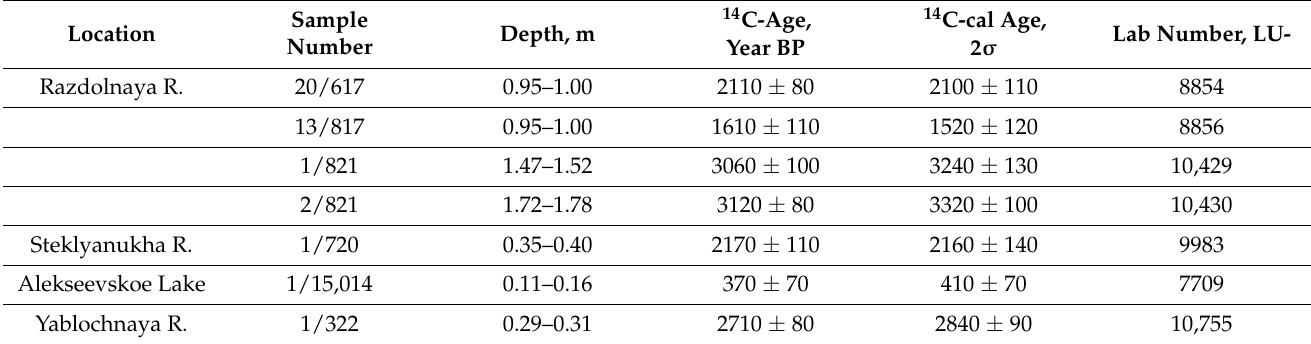
Figure 5. ( a ) Paleosol and deposits of strong floods on the floodplains of Razdolnaya (Suifun) River near Starorechenskoe Fortress, Southern Primorye (site 24 on Figure 2); ( b ) Deposits of the floodplain, Kurilka River, Iturup Island, Southern Kuril Islands—the deposits include marker tephra layers Ta-a (1739 CE) from the eruption of Tarumai Volcano, Hokkaido. Table 1. Radiocarbon dating results and calibrated ages of the paleosol from flood-plain sequences and wetlands near the mountain lake, Primorye and Sakhalin